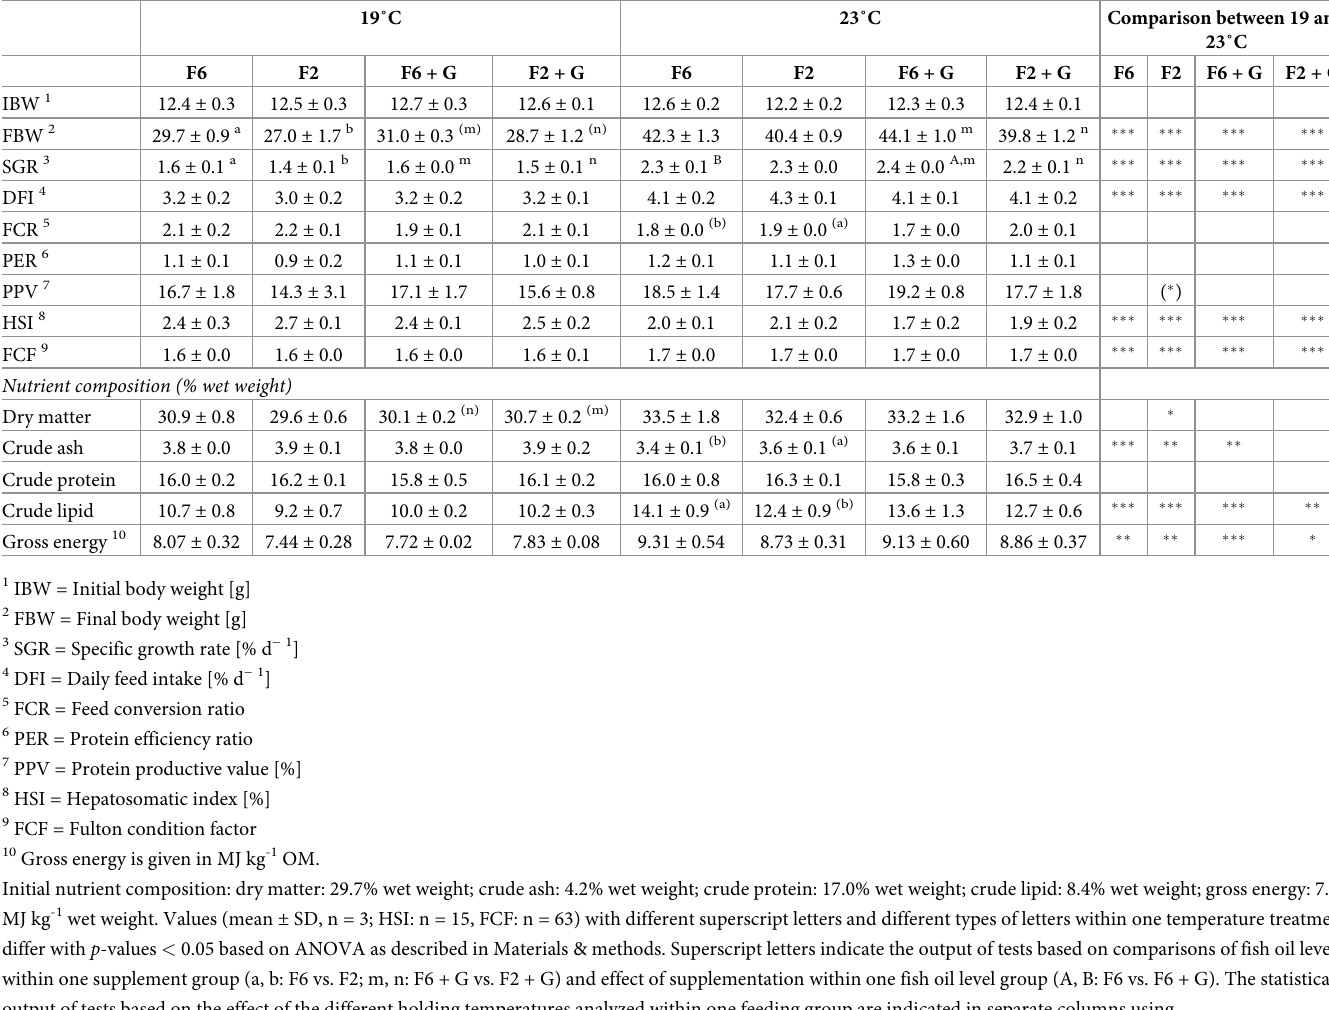
Table 3. Growth performance, nutrient utilization, and final whole body nutrient composition (percentage of wet weight (% wet weight) and MJ kg -1 wet weight) of gilthead sea bream fed with the experimental diets for 8 weeks and held at two different temperatures, 19˚C and 23˚C. F6 and F2 indicate the feeding with the control diets containing 6% and 2% DM fish oil, respectively. +G indicates feeding the diets supplemented with 0.15% DM genistein. 19˚C 23˚C Comparison between 19 and